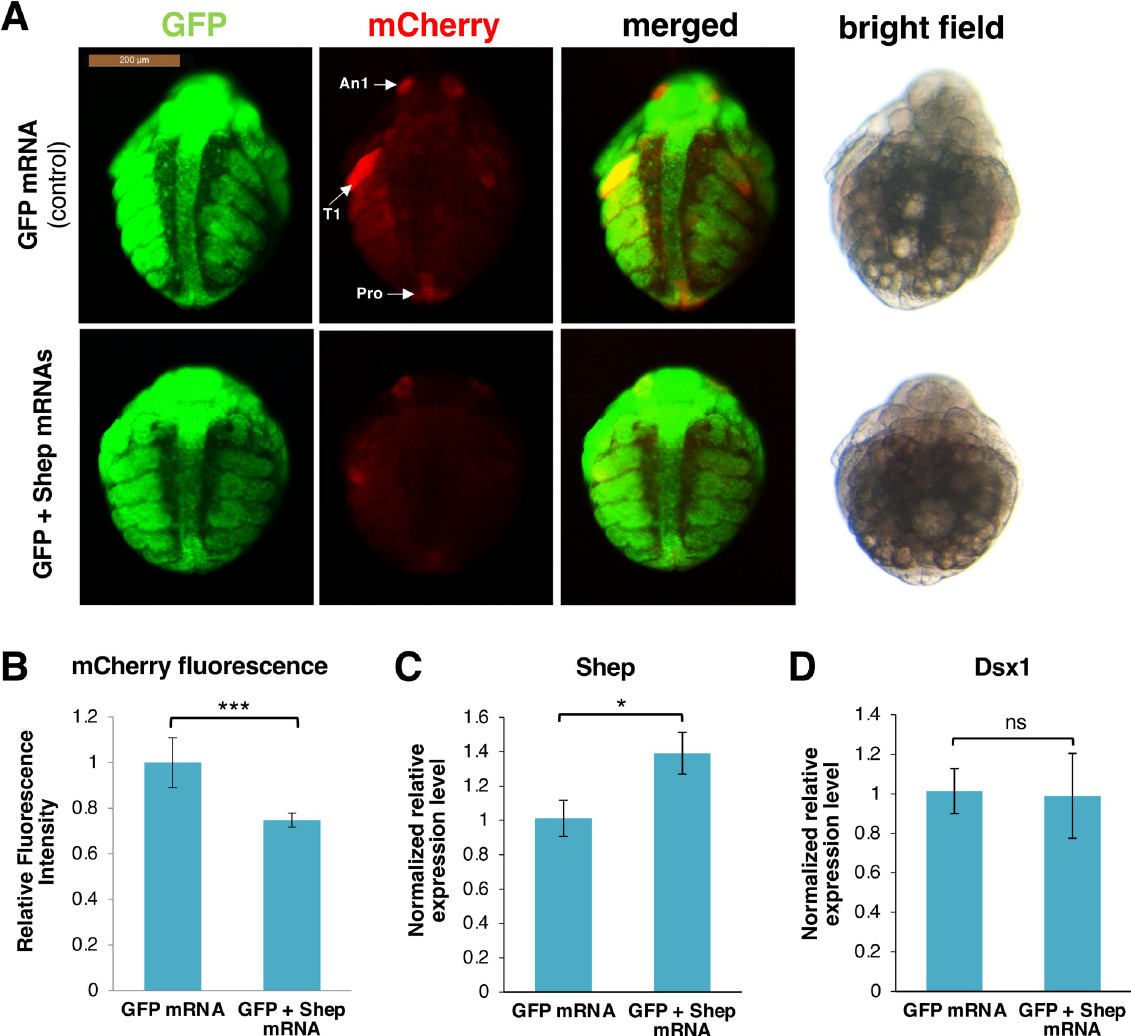
Fig 4. Overexpression of Shep. (A) Ventral view of male embryos of Dsx1 reporter strain injected with GFP mRNA as control and GFP plus Shep mRNA observed at 30 h after injection. mCherry fluorescence allowed visualization of Dsx1 expression while GFP fluorescence in the nucleus enabled observation of body structures. The merged images of mCherry and GFP and the bright field images were used to understand the localization pattern of mCherry expression. An1: first antennae, T1: first thoracic legs, Ge: genital. (B) Relative mCherry fluorescence intensity calculated between GFP mRNA- and GFP plus Shep mRNA-injected male embryos. Error bars indicate the standard error of the mean (n = 5). (C) Gene expression profile of Shep in GFP mRNA- and GFP plus Shep mRNA-injected male embryos. (D ) Gene expression profile of Dsx1 in GFP mRNA- and GFP plus Shep mRNA-injected male embryos. RT-qPCR results are shown as expression levels normalized with housekeeping genes L32 , L8 and Cyclophilin and relatively compared to the control. Error bars indicate the standard error of the mean (n = 3). � p < 0.05, ��� p < 0.001, ns: not significant (Student’s